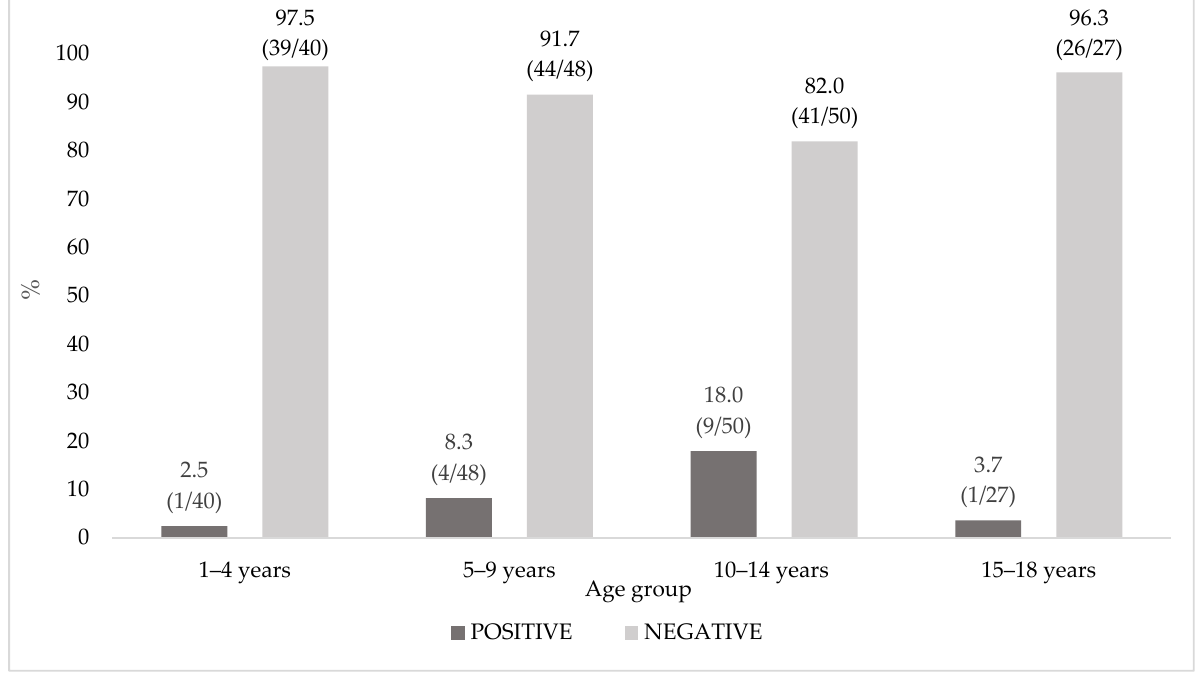
Figure 1. Seroprevalence distribution in the age groups. Note: Percentages and ratios ( n / N ) are shown above each bar. A statistically significant difference in seroprevalence was observed in the non-Italian group (higher seroprevalence) compared to individuals having an Italian nationality (lower